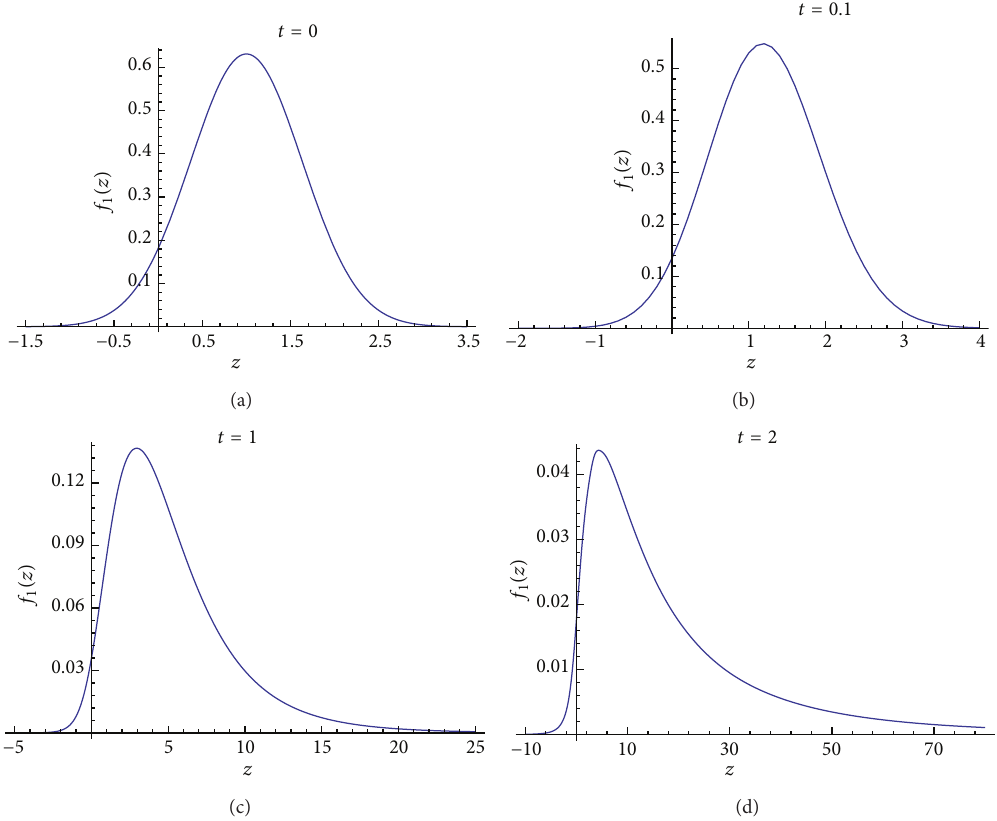
Figure 14: Plots of 𝑓 1 (𝑧,𝑡) given by (159) in Example 24 at different values of 𝑡 with 𝑡 0 = 0 in the case that (𝑍 0 ,𝐵,𝐴) is a three-dimensional Gaussian vector with mean and variance-covariance matrix given by